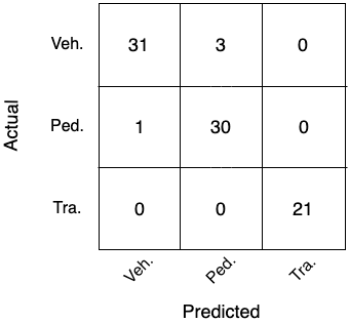
Figure 8. Confusion Matrix for PointNet trained with original + synthetic segments